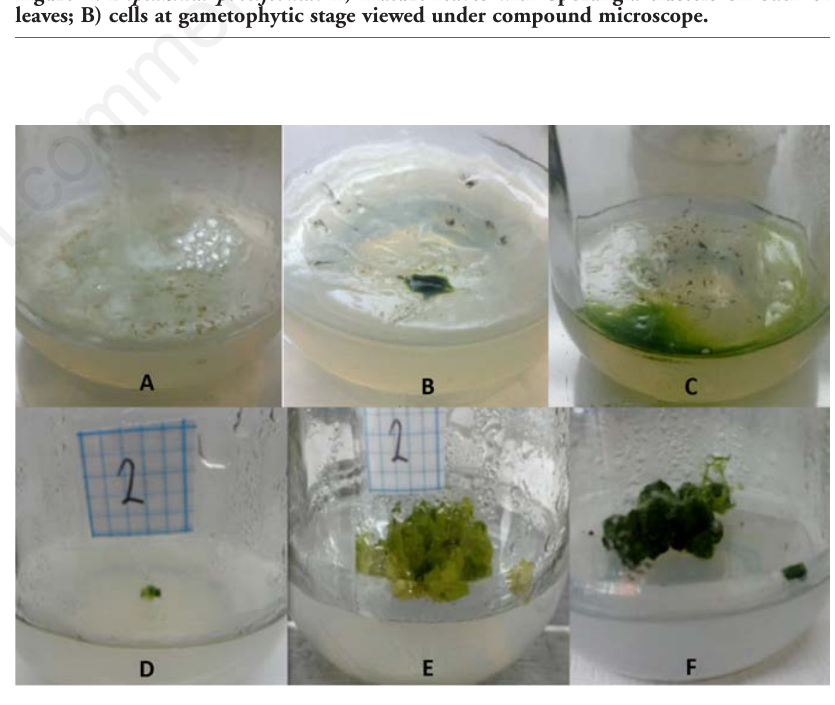
Figure 2. A-C) The development of spores to gametophytic stage: A) inoculated spores, B) initial growth of gametophytes, C) slurry of gametophytes. D-F) Development of sporophyte to small plantlets shoots: D) initial subcultured tissue, E) increase in size of sporophyte, F) appearance of first